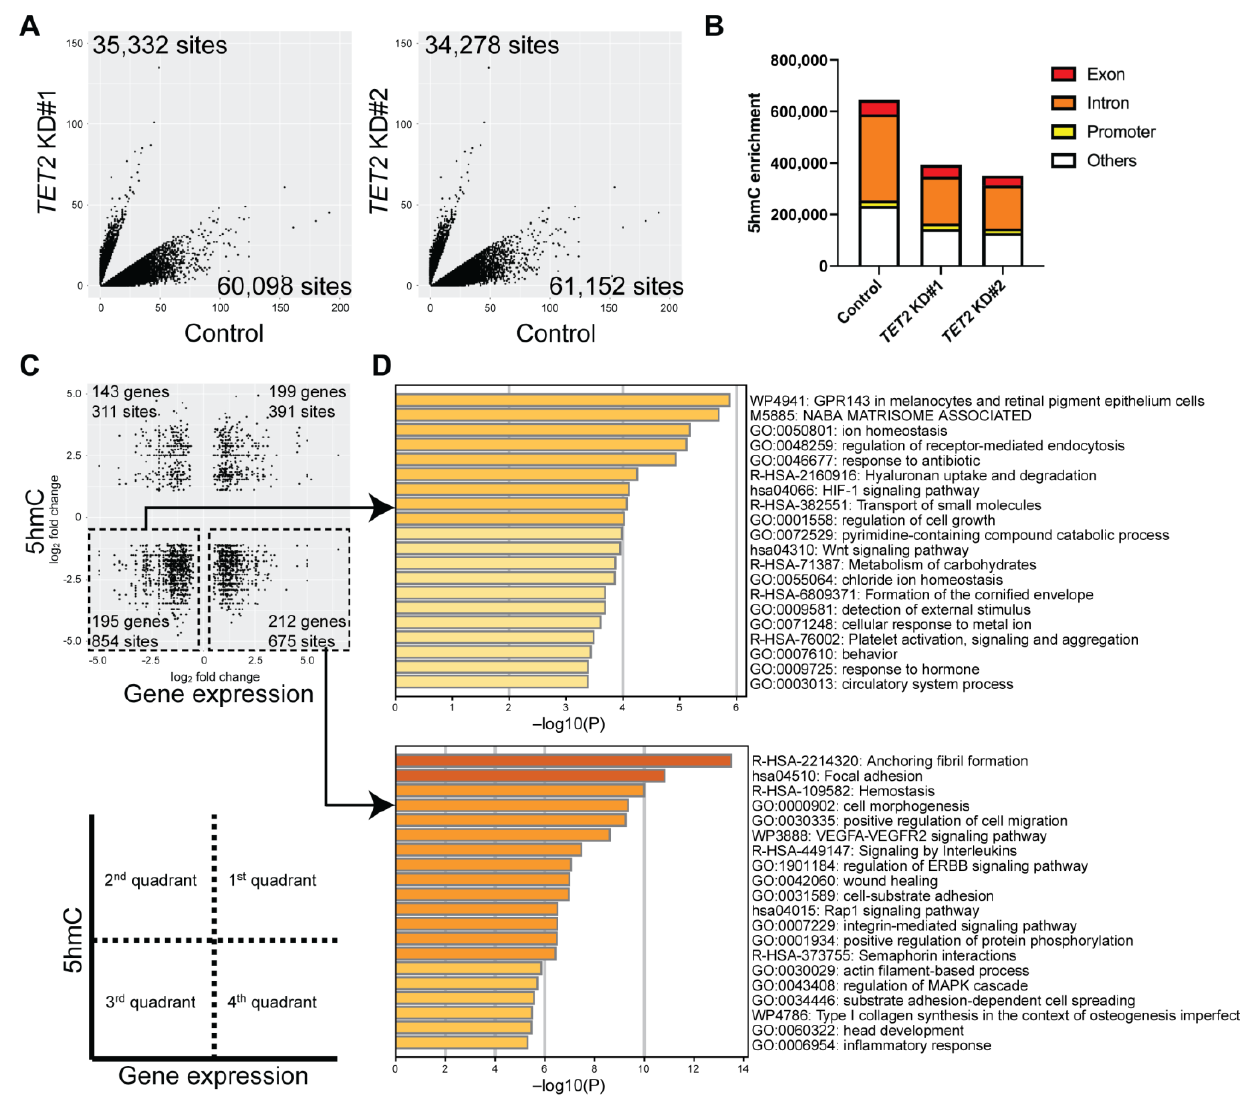
Figure 4. Identification of epigenetically regulated pathways through integration of RNA-seq and Reduced Representation Hydroxymethylation Profiling (RRHP) analyses of TET2 KD cells. ( A ) Scatter plots of 5hmC enrichment in TET2 KD#1 ( left ) and TET2 KD#2 ( right ) cultures. ( B ) Bar graphs represent the distribution of 5hmC site numbers in exon, intron, and promoter regions. ( C ) Scatter plots depict the correlation between the DEGs ( x -axis) and corresponding differentially enriched 5hmC levels ( y -axis) shared between TET2 KD#1 and TET2 KD#2 cultures selected as described in methods. ( D ) Metascape enrichment analysis of the downregulated ( top ) and upregulated ( bottom ) DEGs with reduced 5hmC